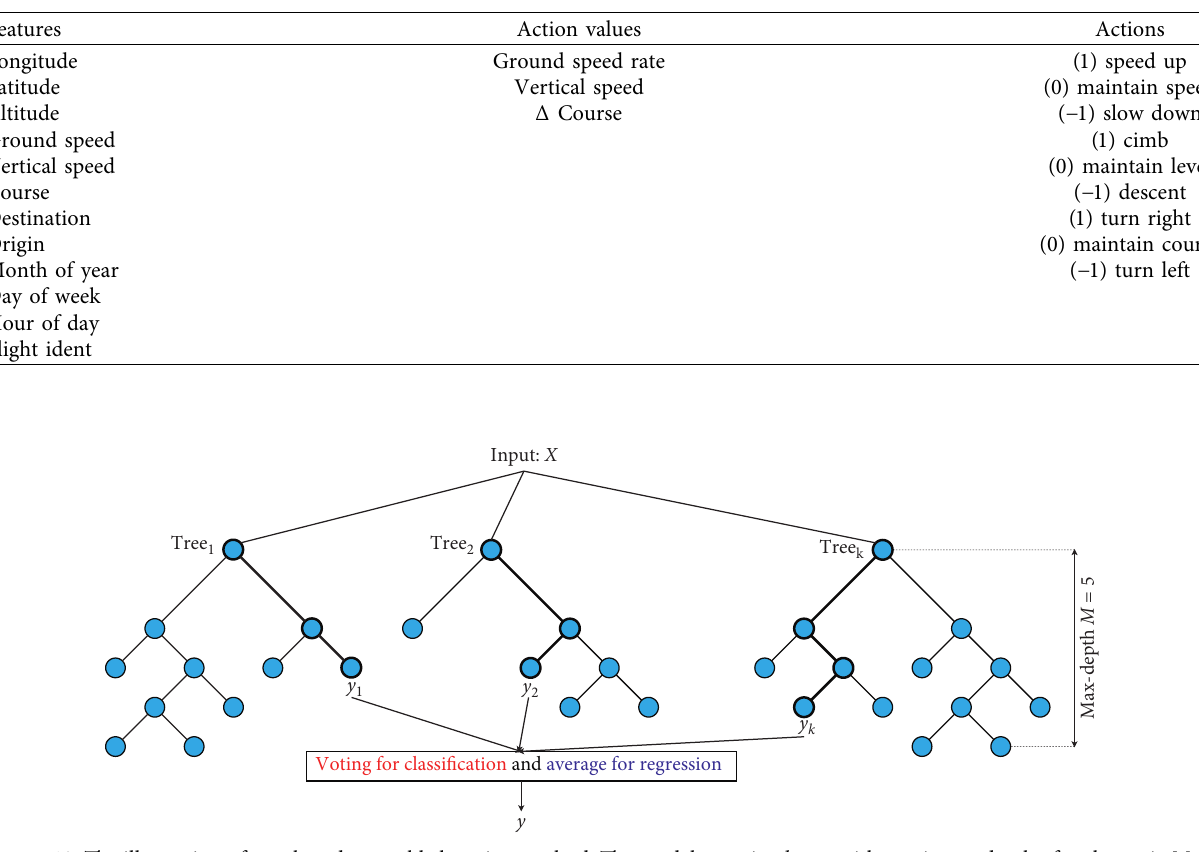
Table 4: Flight information (features) at entry point and actions and their values.